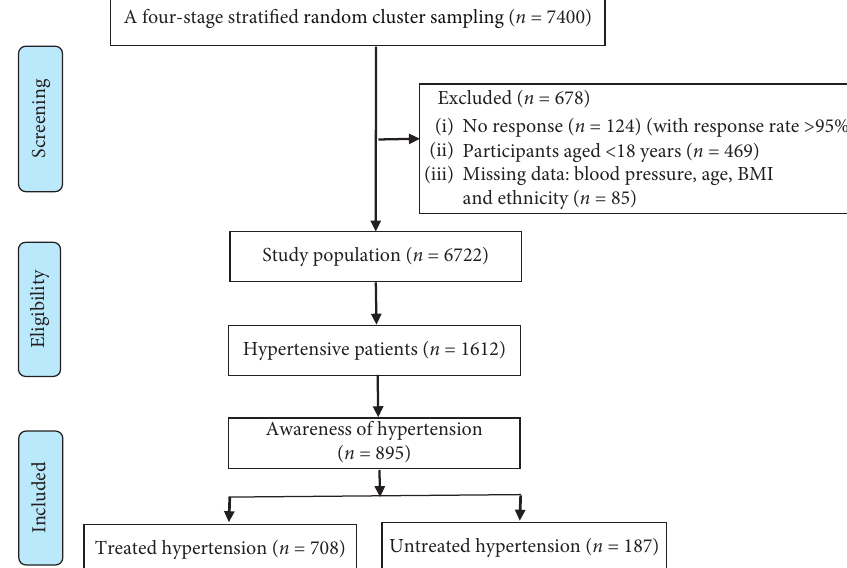
Figure 1: The flow chart of inclusion and screening of surveyed